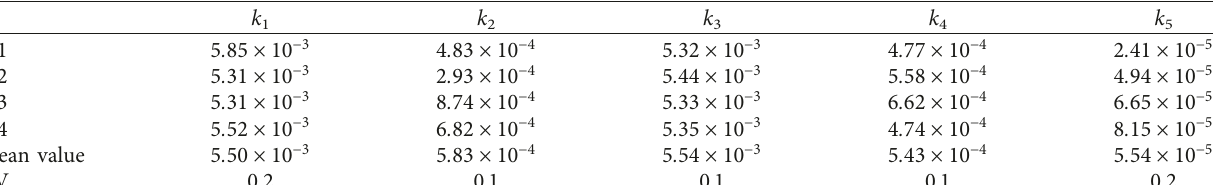
Table 2: Values of reaction rate constant k